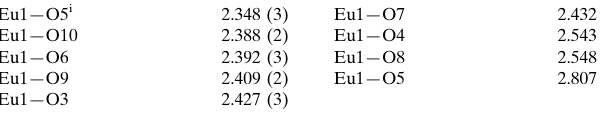
Selected bond lengths (A˚ ).